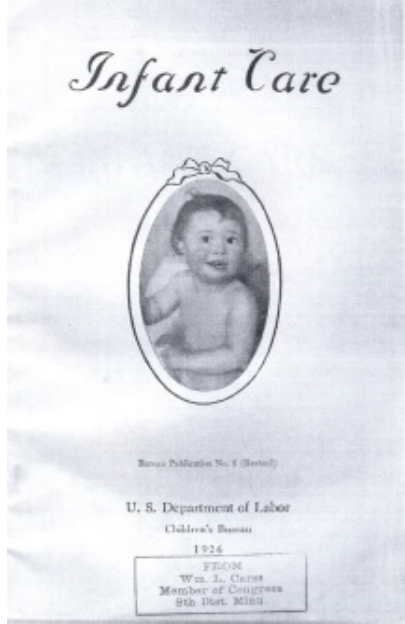
Figure 31. Outside Cover of 1926 edition of Infant Care .